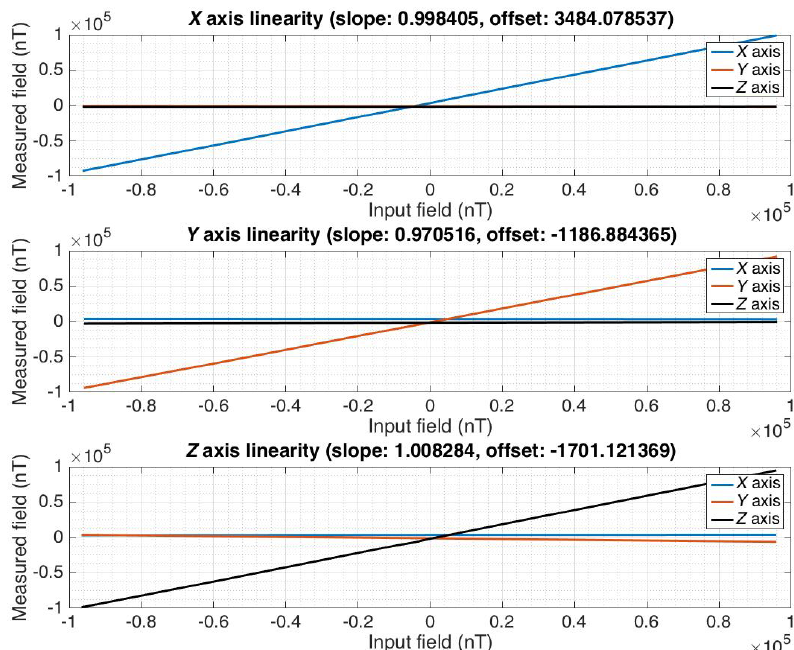
Figure 9. Results of the linearity test shown as the output (measured) field vs. input (applied) field for the three axes of the magnetometer.